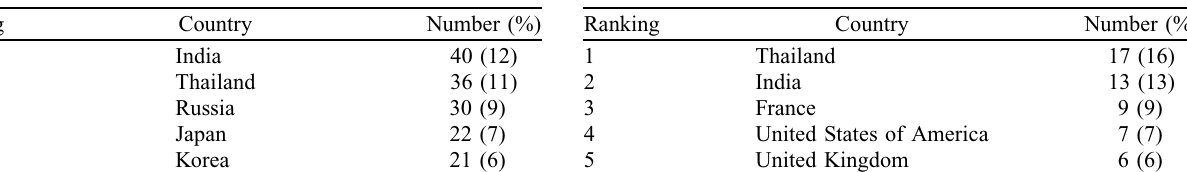
Table 2. Showing the top five countries with presented oral abstracts. Total N = 329.